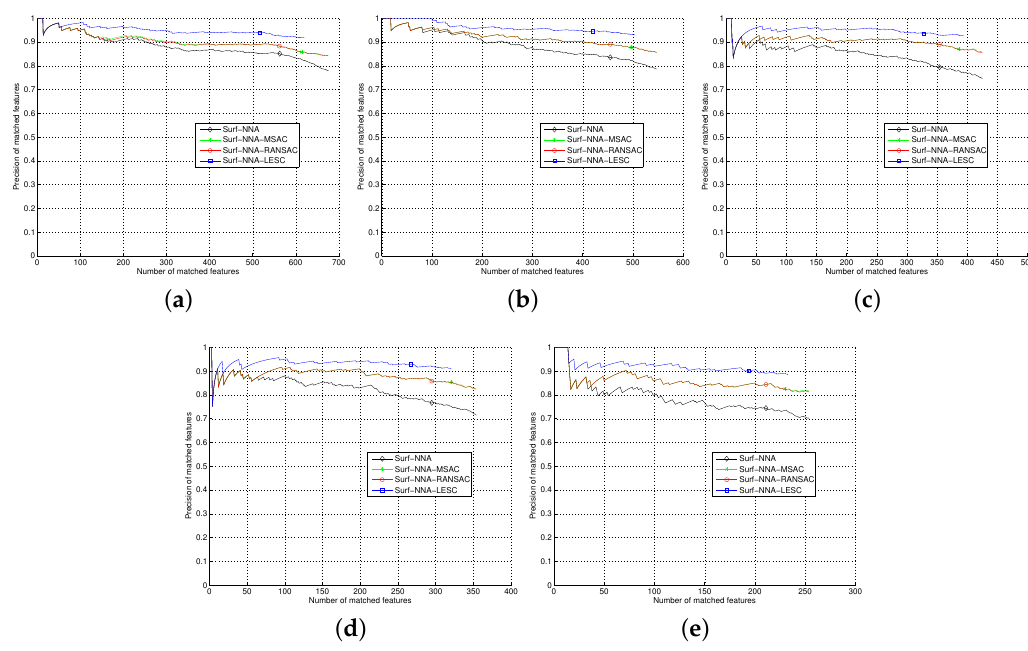
Figure 6. Illumination change by the Leuven sequence. From ( a ) to ( e ) the degree of change ascends.